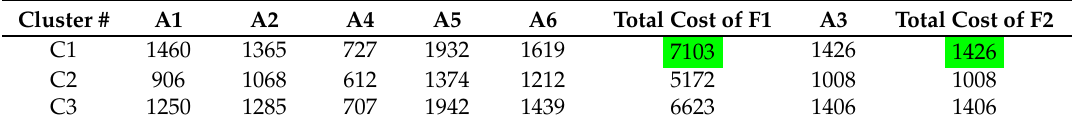
Table 18. TACC fragments allocation over site clusters of our proposed